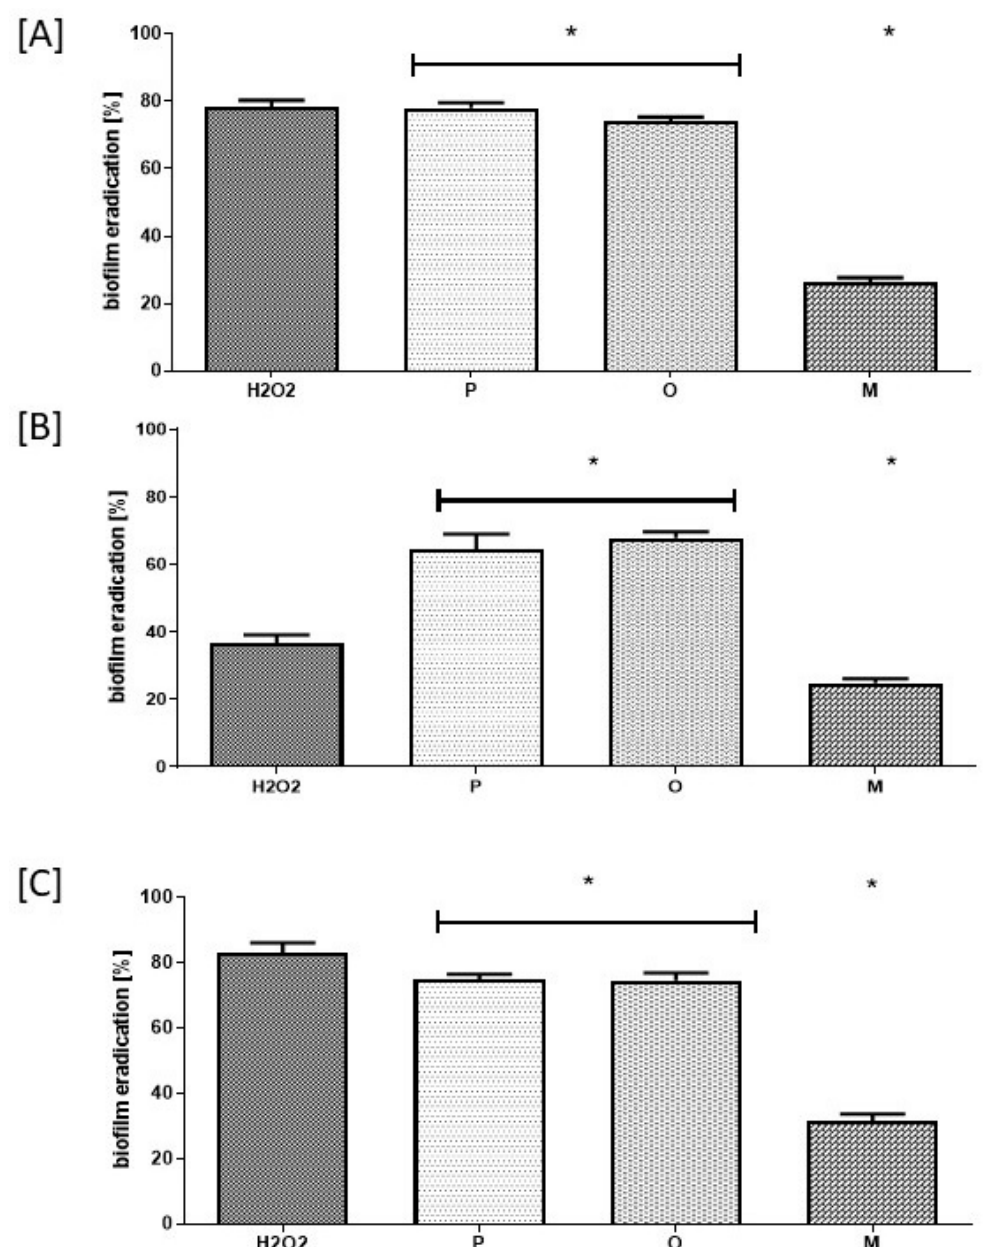
Figure 3. Eradication of ( A ) C. albicans ; ( B ) S. aureus , ( C ) P. aeruginosa biofilm from fibriblast-covered cellulose carrier by P, O and M antiseptics. P, O, M—polihexanide, octenidine dihydrochloride, NaClO/HClO-based antiseptics, respectively. H 2 O 2 of concentration 30% was used as a control of microbial killing, while the number of biofilm-forming cells immersed in saline were considered 100% of potential microbial viability. The asterisks (*) represent statistical significance ( p < 0.05) between individual antiseptics’ activity.